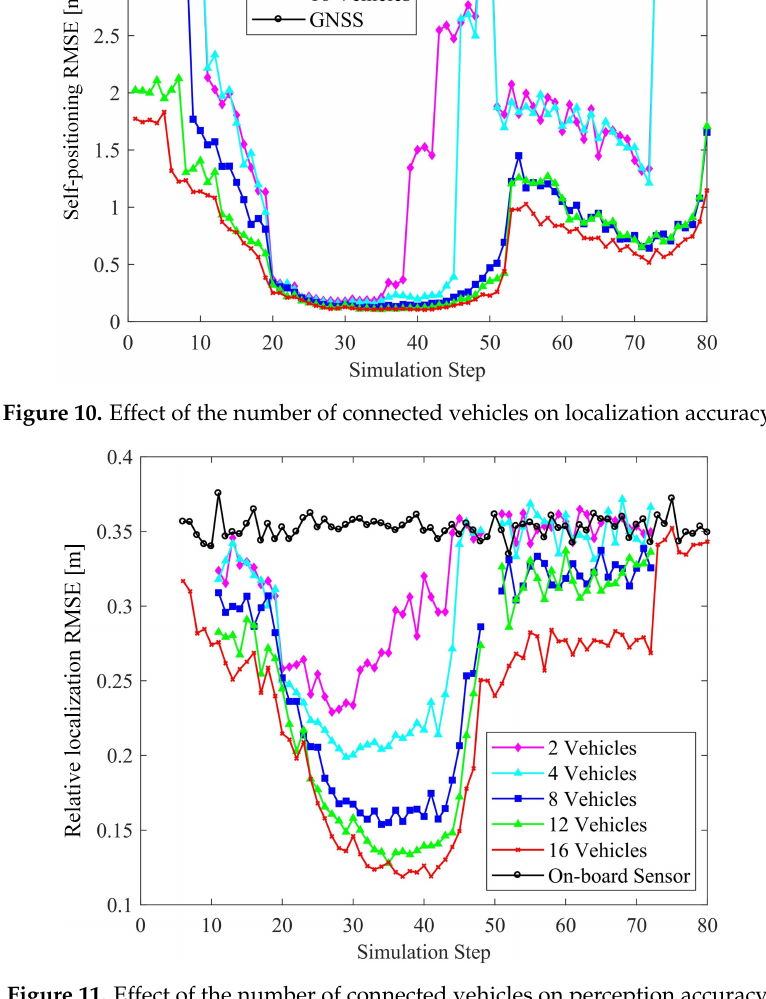
Figure 11. Effect of the number of connected vehicles on perception